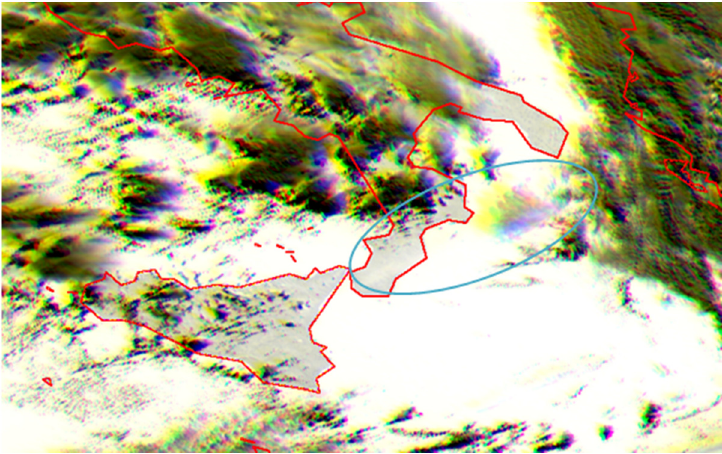
Figure 6. Color composite image representing the comparison of the situation as seen by the two sensors at about 11:49 UTC. This figure visually highlights the parallax between MVIRI and SEVIRI in yellow, and the effects of wind between the two SEVIRI images in turquoise. The volcanic cloud is marked by a blue ellipse.